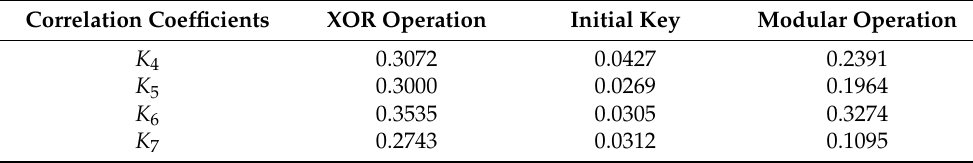
Table 4. Correlation coefficients of electromagnetic signals with XOR operation, initial key, and modular operation as labels,